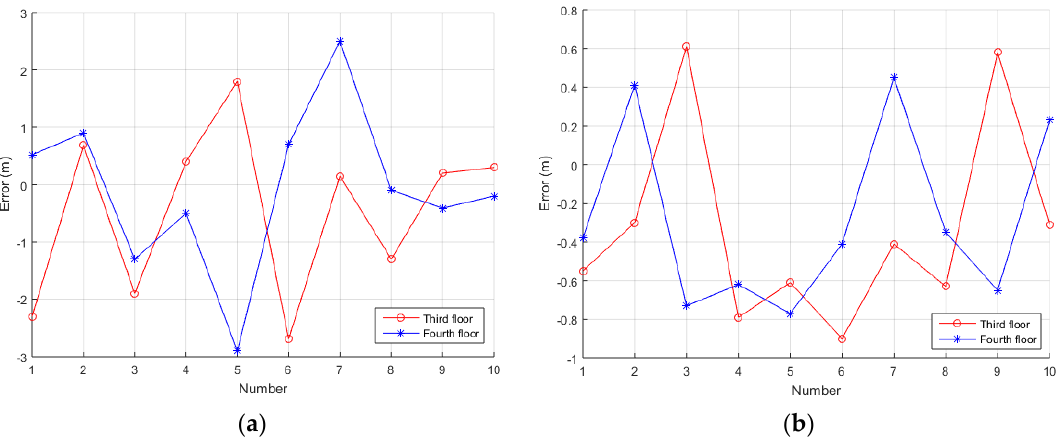
Figure 20. The positioning accuracy of the entire system: ( a ) is horizontal accuracy and ( b ) is vertical accuracy.